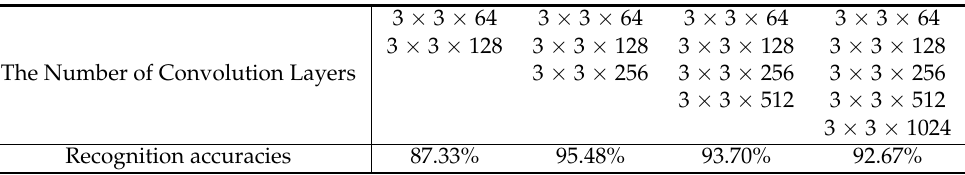
Table 2. Recognition accuracies vs. Number of convolution